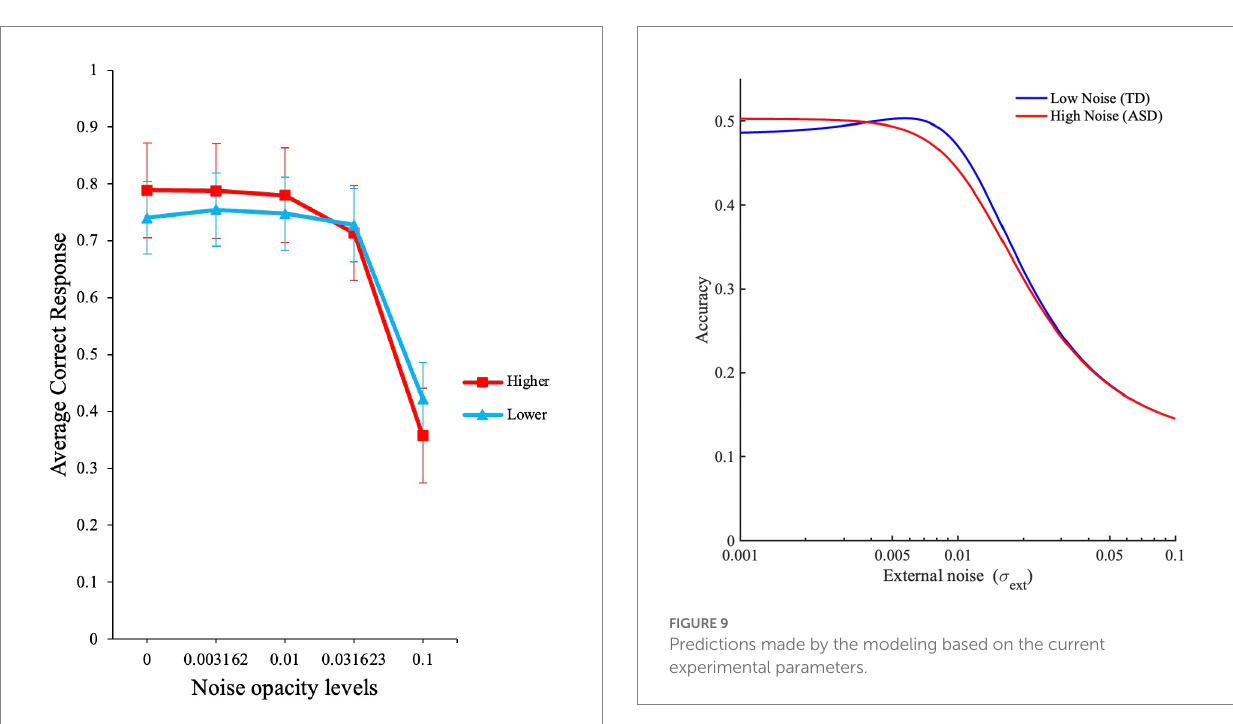
FIGURE 8 Participant’s performance based on higher and lower AQ. The graph illustrates the raw average accuracies for participants with higher and lower AQ traits. Error bars show standard errors of the means.